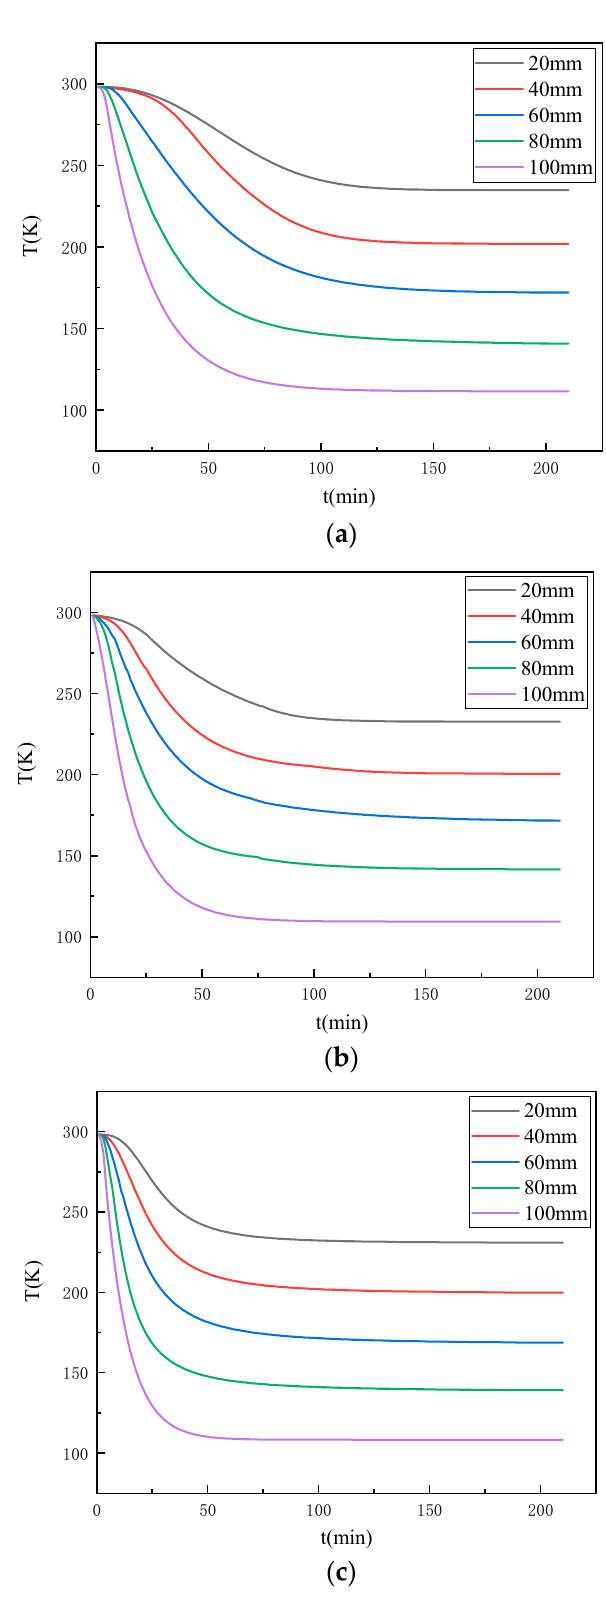
Figure 4. The temperature change at different points for coal samples with different water contents: ( a ) 0%; ( b ) 4.23%; ( c ) 8.76%.